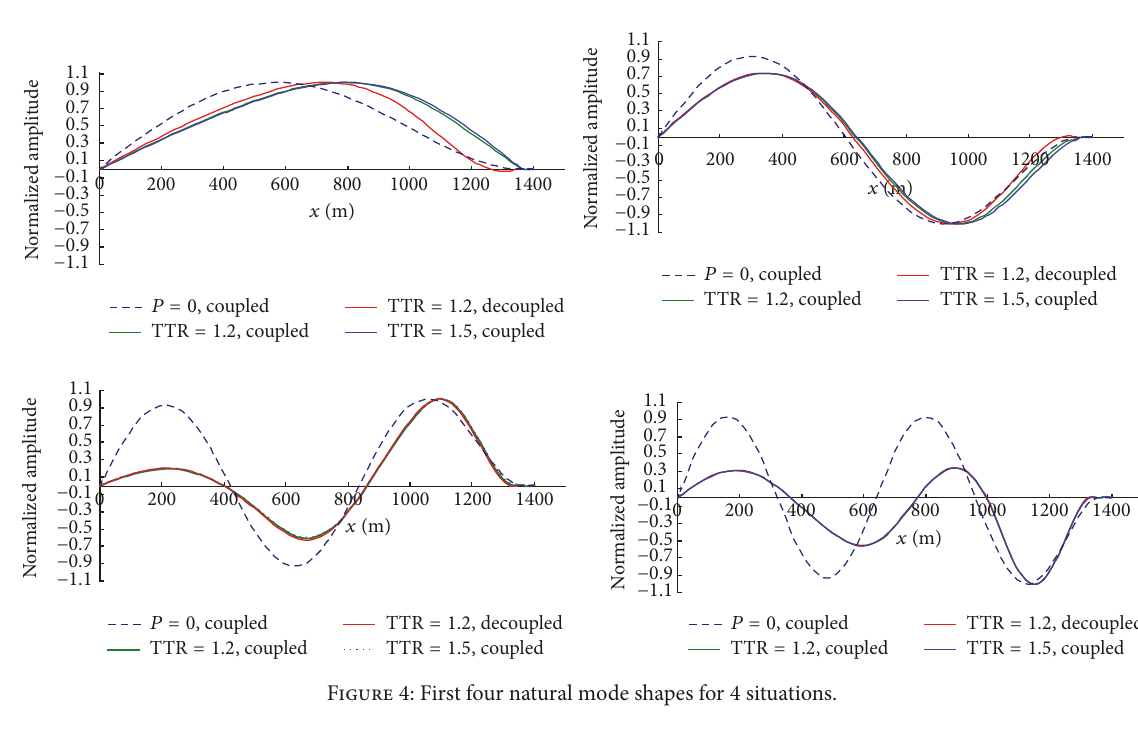
Figure 4: First four natural mode shapes for 4 situations.